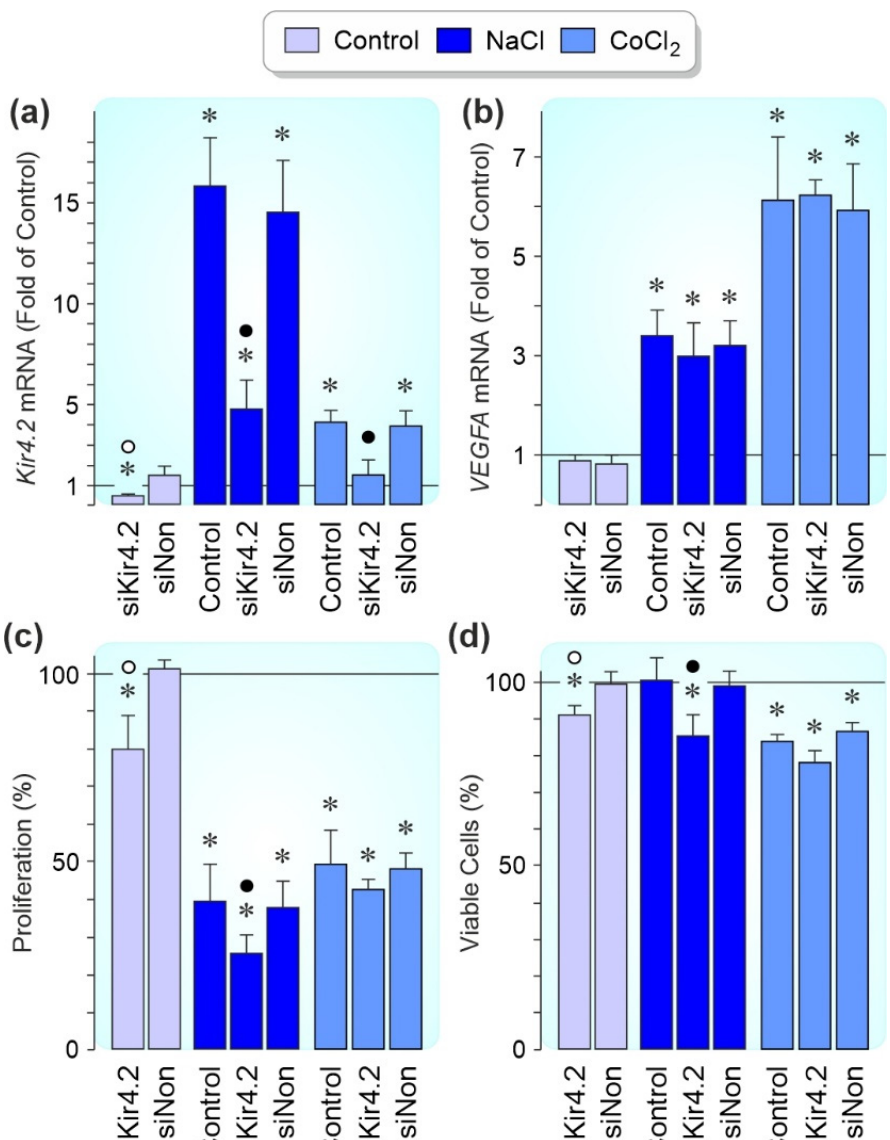
Figure 7. Kir4.2 knockdown affects the proliferation and viability of cultured RPE cells. The expression levels of the Kir4.2 gene ( a ) and the VEGFA gene ( b ), the proliferation rate ( c ), and the viability ( d ) were investigated in cells transfected with Kir4.2 siRNA (siKir4.2) and nontargeted siRNA (siNon). The cells were cultured 24 h in the absence and presence of high (+100 mM) NaCl and CoCl 2 (150 µM), respectively, as indicated by the panels of the bars. The data are shown as fold (1; ( a , b )) and percent of unstimulated, nontransfected control cells (100%; ( c , d )), respectively. Each bar represents data obtained in 4–10 independent experiments using cells of different donors. Significant difference vs. unstimulated, nontransfected control cells: * p < 0.05. Significant difference vs. NaCl and CoCl 2 control, respectively, and transfection with siNon: ● p < 0.05. Significant difference between siKir4.2 and siNon: ○ p < 0.05.